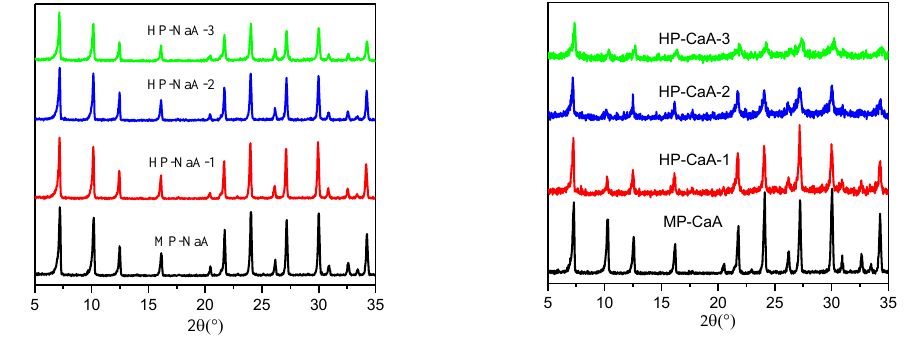
Figure 1. XRD spectra of NaA and CaA zeolites.